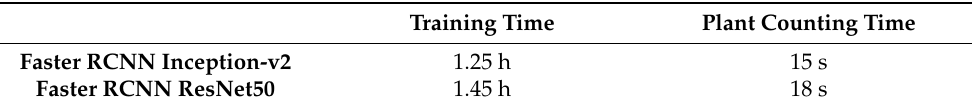
Table 4. Training time and plant counting time for the Faster RCNN Inception-v2 and Faster RCNN ResNet50 models. The plant counting time includes all the time required along the proposed pipeline for a raw mung bean data file consisting of 12